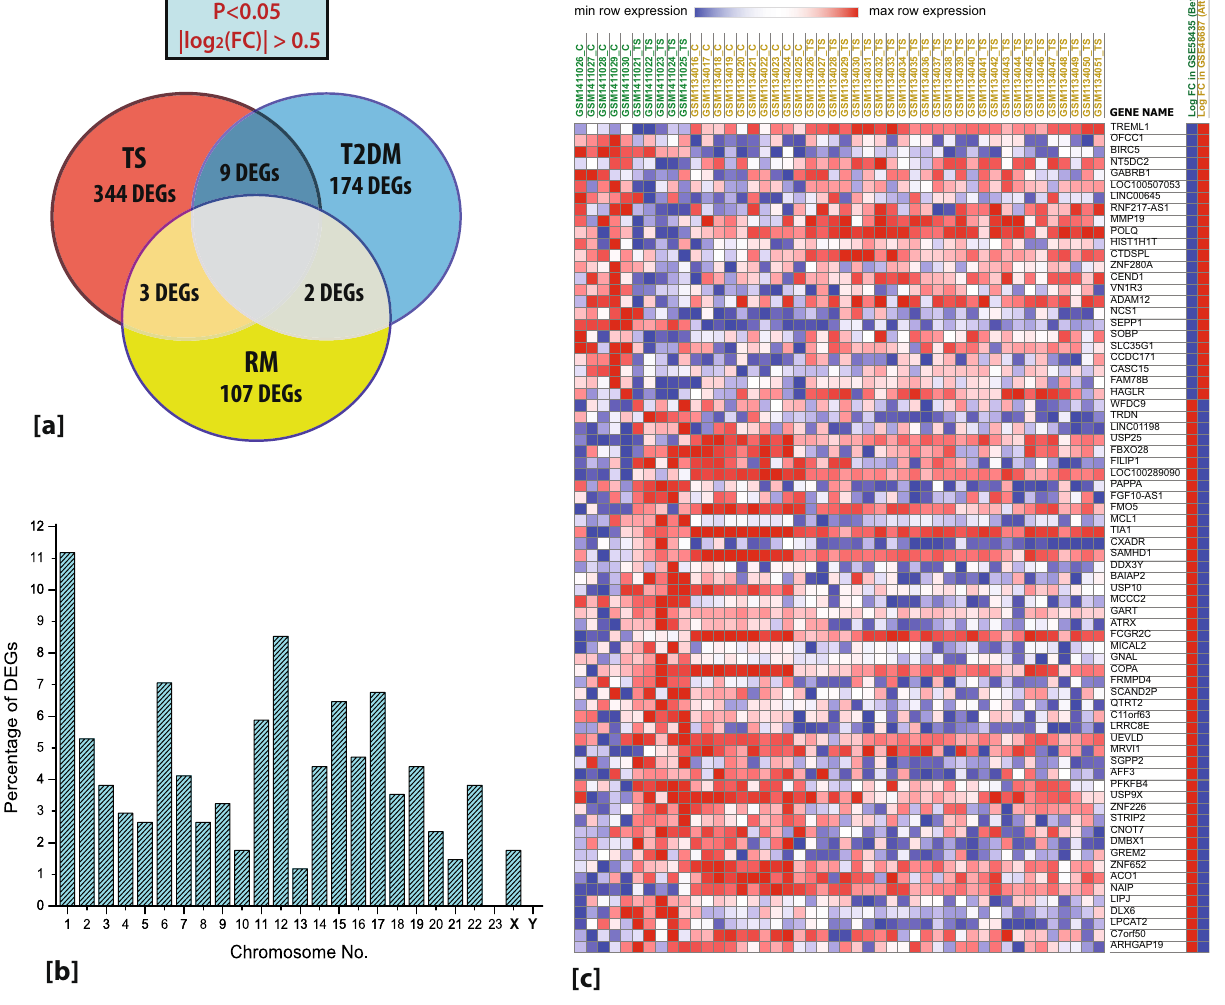
Figure 2. ( a ) Signature genes of T2DM and RM in TS. ( b ) The percentage of genes on each chromosome that was differentially expressed in TS at the significance threshold “P-value < 0.05” and “|logFC|≥ 0.5”. ( c ) The heat map showing the change in expression of the DEGs from TS fetus (GSE58435) to TS adult (GSE46687).